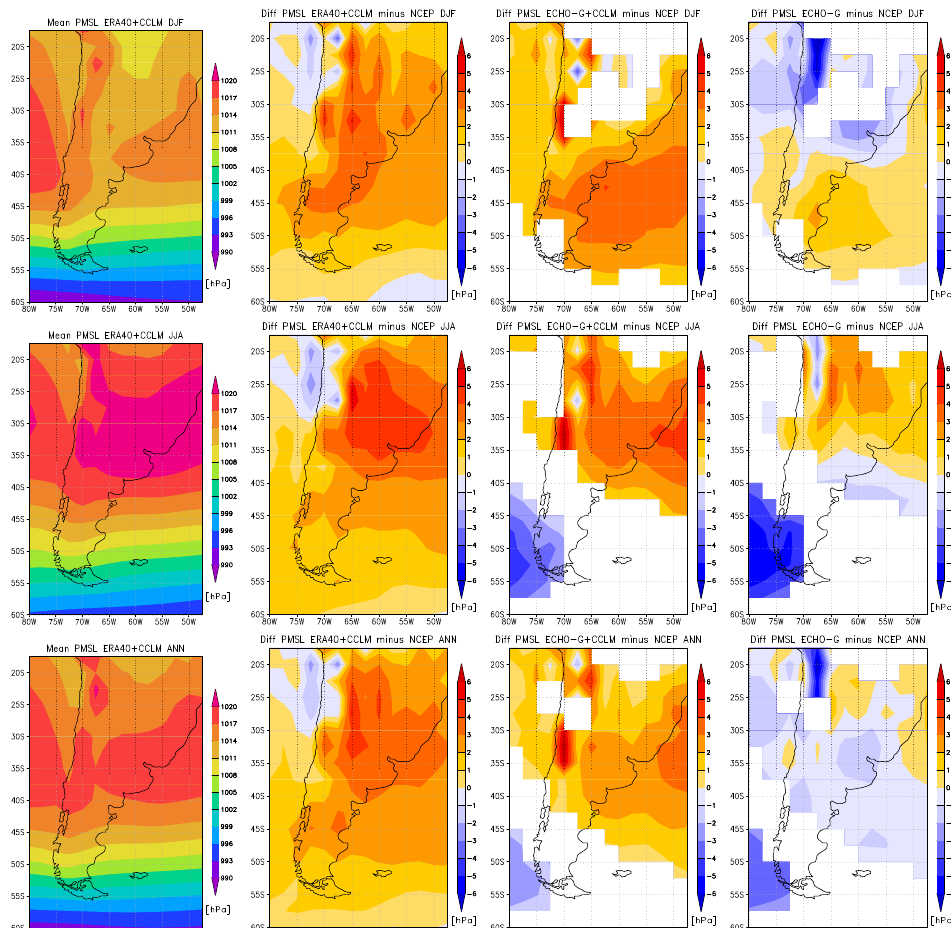
Fig. 5. same as Fig. 3 except for sea-level pressure. As reference the NCEP/NCAR dataset has been Figure 5 : same as Figure 3 except for sea level pressure. As reference the NCEP/NCAR data set has been used.